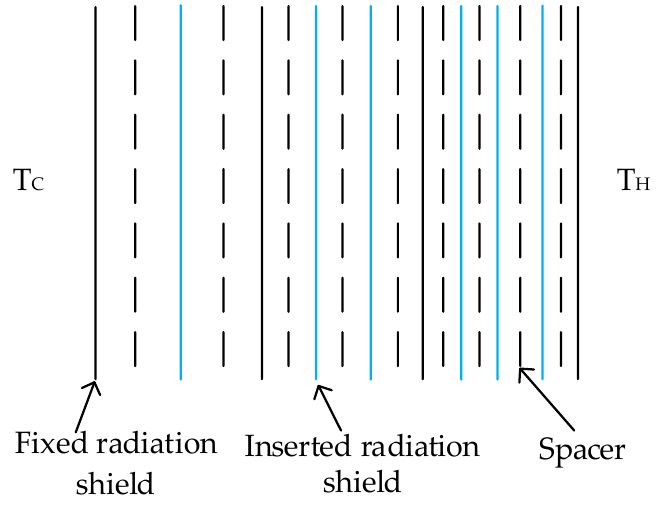
Figure 3. Schematic of the variable density configuration.